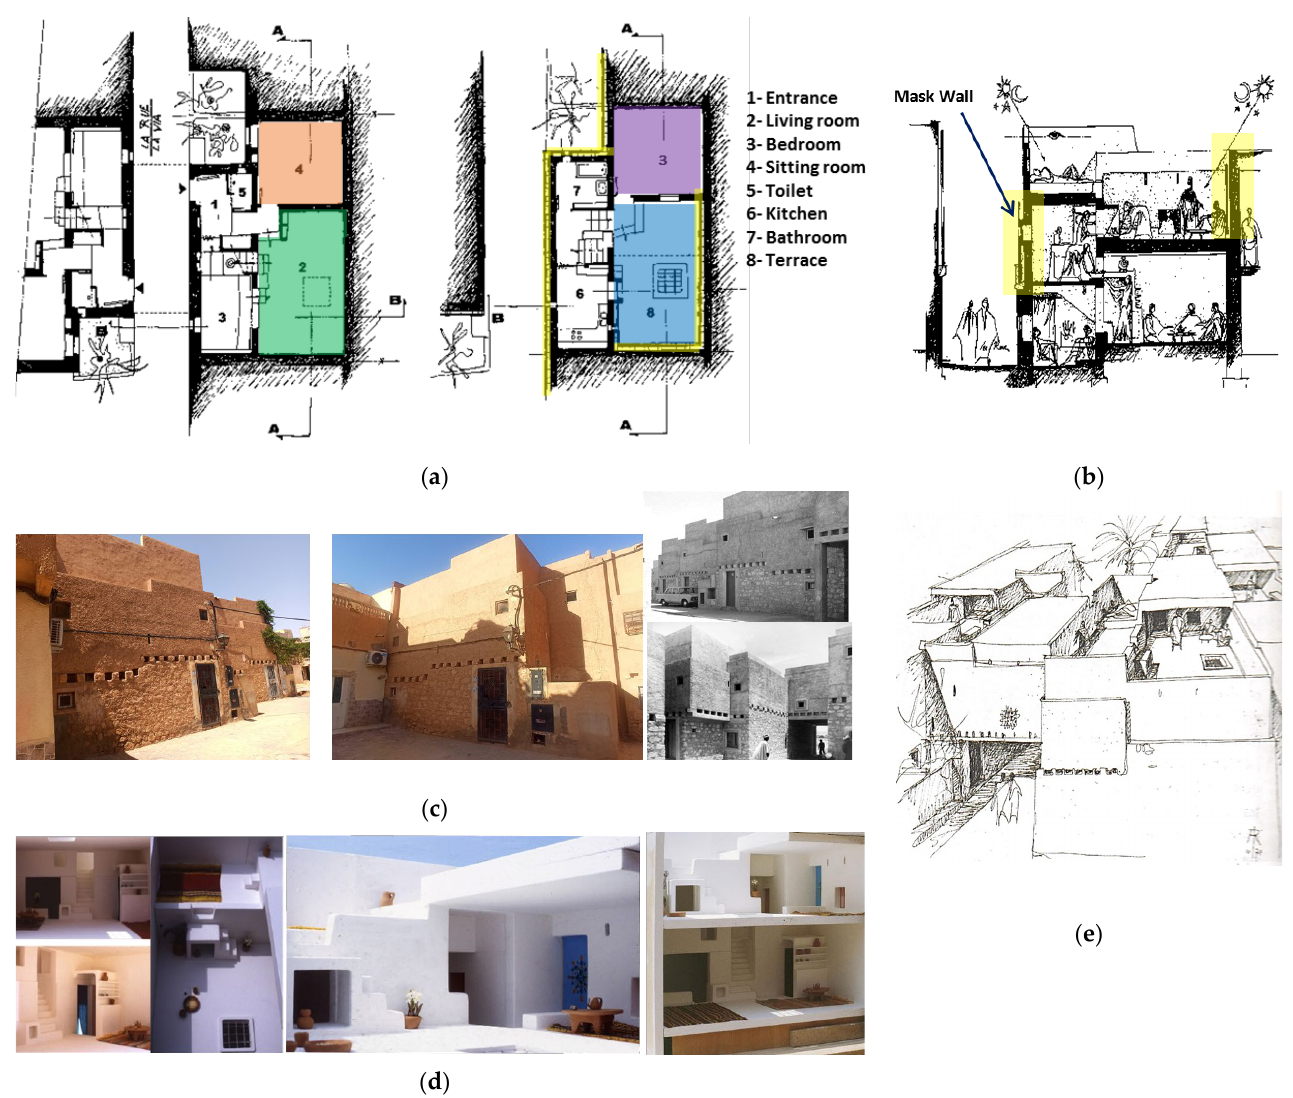
Figure 3. Plans, section and views on Sidi Abbaz’s neo-vernacular dwelling: ( a ) Ground floor plan ( left ) and first-floor plan ( right ) showing the monitored rooms; ( b ) Section B-B showing the mask wall; ( c ) exterior views of the dwelling; ( d ) interior views on a small scale model of the dwelling; ( e ) Ravereau’s freehand sketching showing a general view on the terraces and a covered alleyway [44,47].